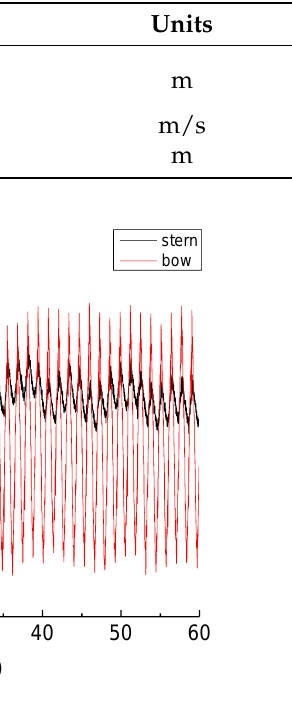
Figure 6. The contact force between vessel and CBF model. Table 5. Wet-towing conditions (wave height as main